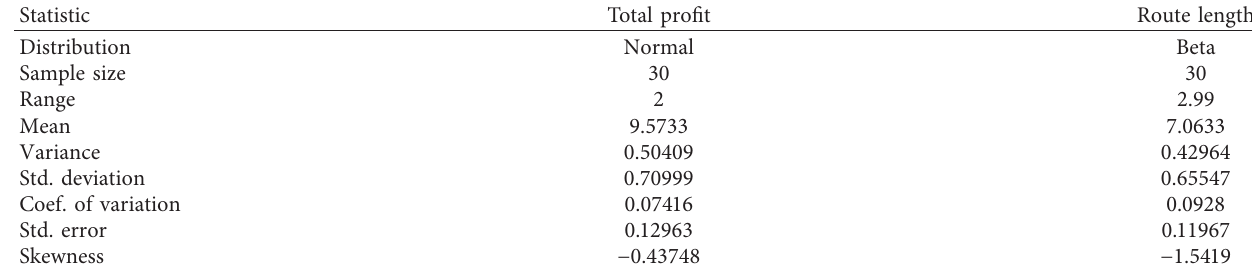
Table 13: Descriptive statistics for the total profit and route